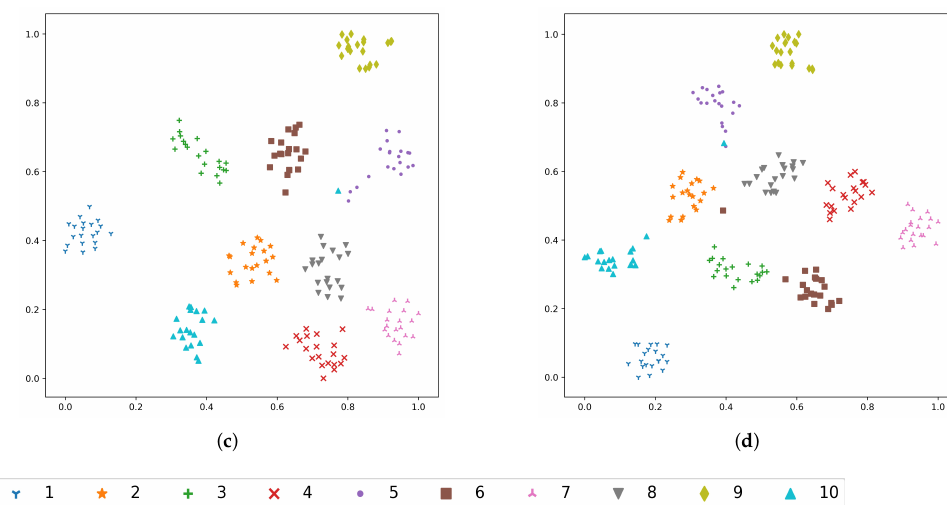
Figure 3. Two-dimensional representation of the speaker embeddings generated by various CNN- based SV systems: ( a ) SAP, ( b ) SAP-SGFSAP-19, ( c ) ASP, ( d ) ASP-SGFSAP-1.